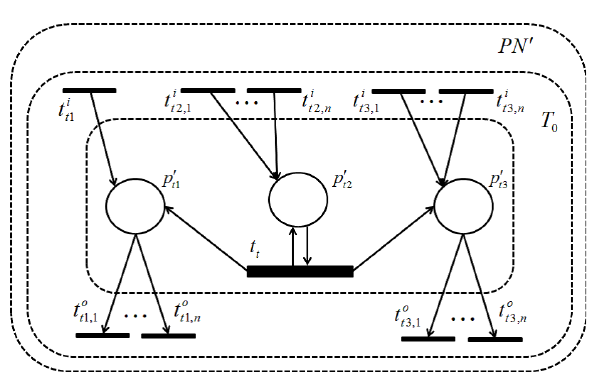
Figure 12. Before shrinking PN t .